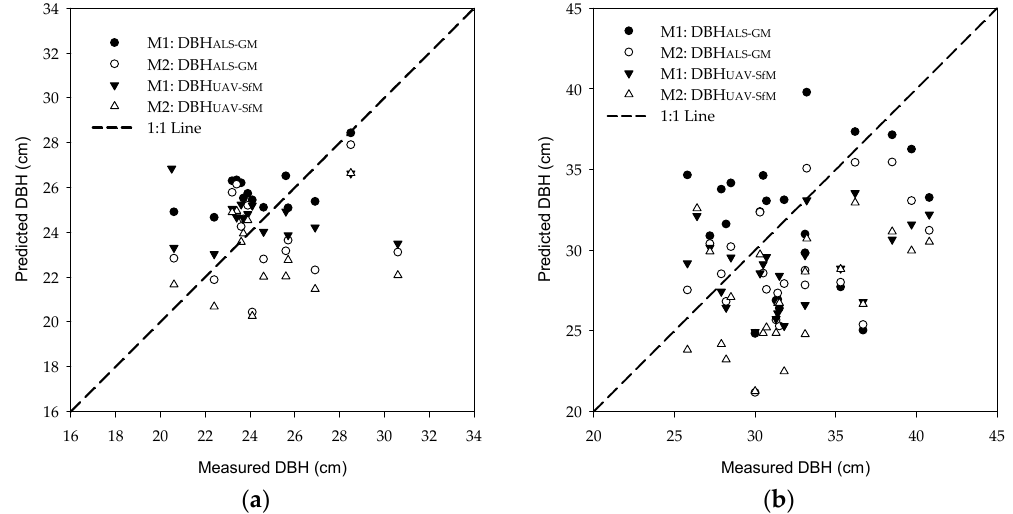
Figure 9. Scatter plot of observations and estimates of tree diameter for the inventory plots in Kameyama ( a ) and Owase forests ( b ). In ( a , b ), the dot and circle represent the estimation of Model-1 (Equation (5)) and Model-2 (Equation (6)) through the ALS-GM datasets, and the black triangle and white triangle stand for the estimation of Model-1 and Model-2 through the UAV-SfM datasets. Please see Table 6 for the details of accuracy measures. Table 6. Summary of diameter estimation and accuracy evaluation for both Kameyama and Owase